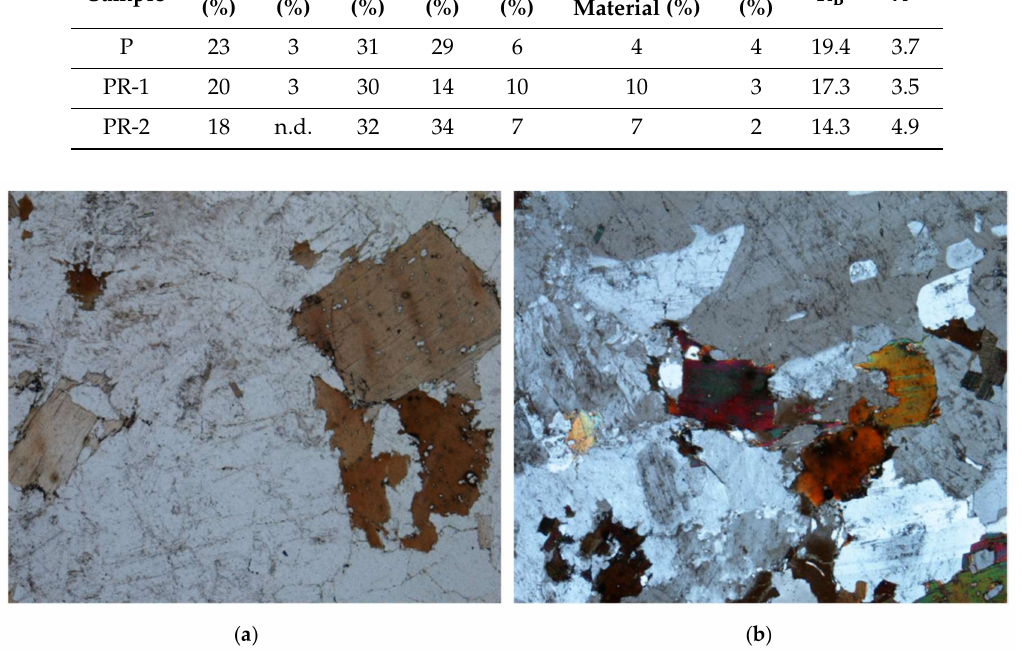
Figure 2. ( a ) Big biotite crystal with zircon inclusions and feldspar crystals (white light X64). ( b ) Quartz altered feldspars and biotite crystals (polarized light X64).